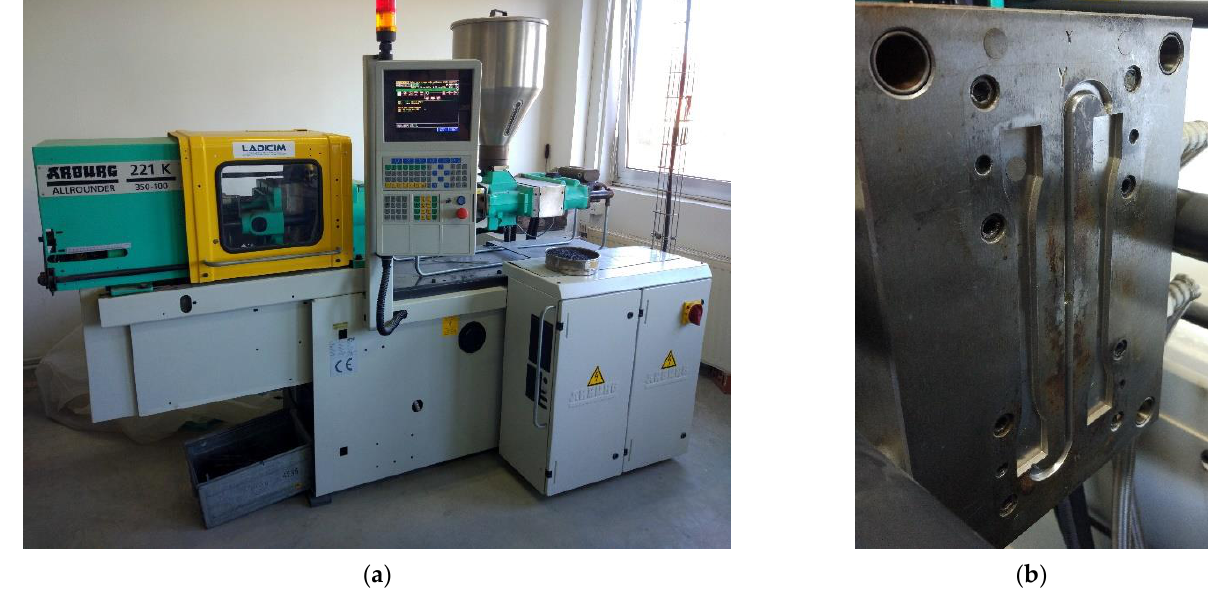
Figure 2. ( a ) Injection machine. ( b ) Mould used for standardised test specimens.